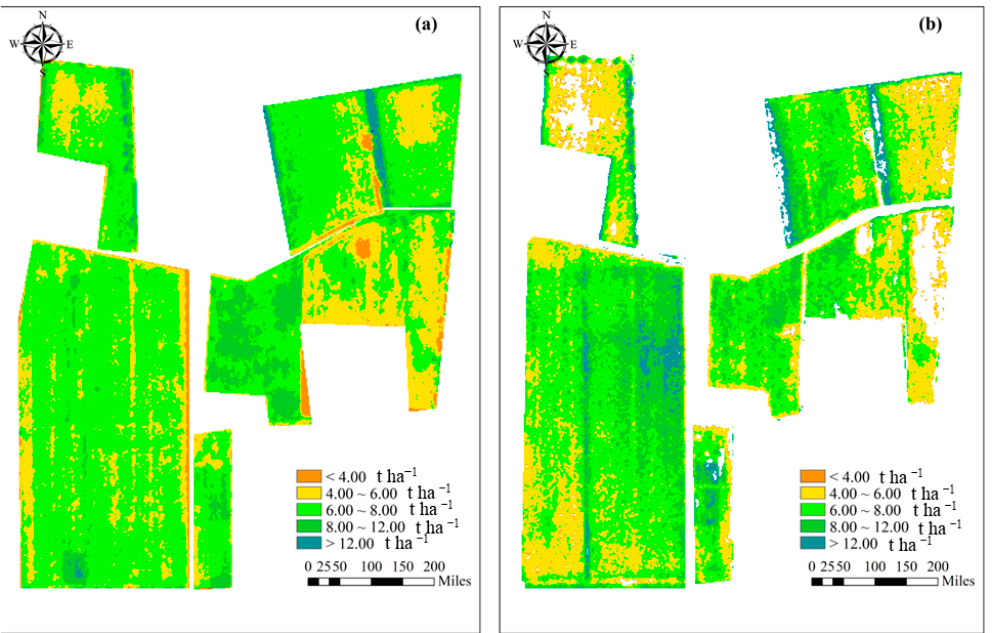
Figure 10. Winter wheat yield maps over experimental seasons: ( a ) 2018 and ( b ) 2019 at Xiaotangshan derived using Planet satellite imagery with the transfer learning models.